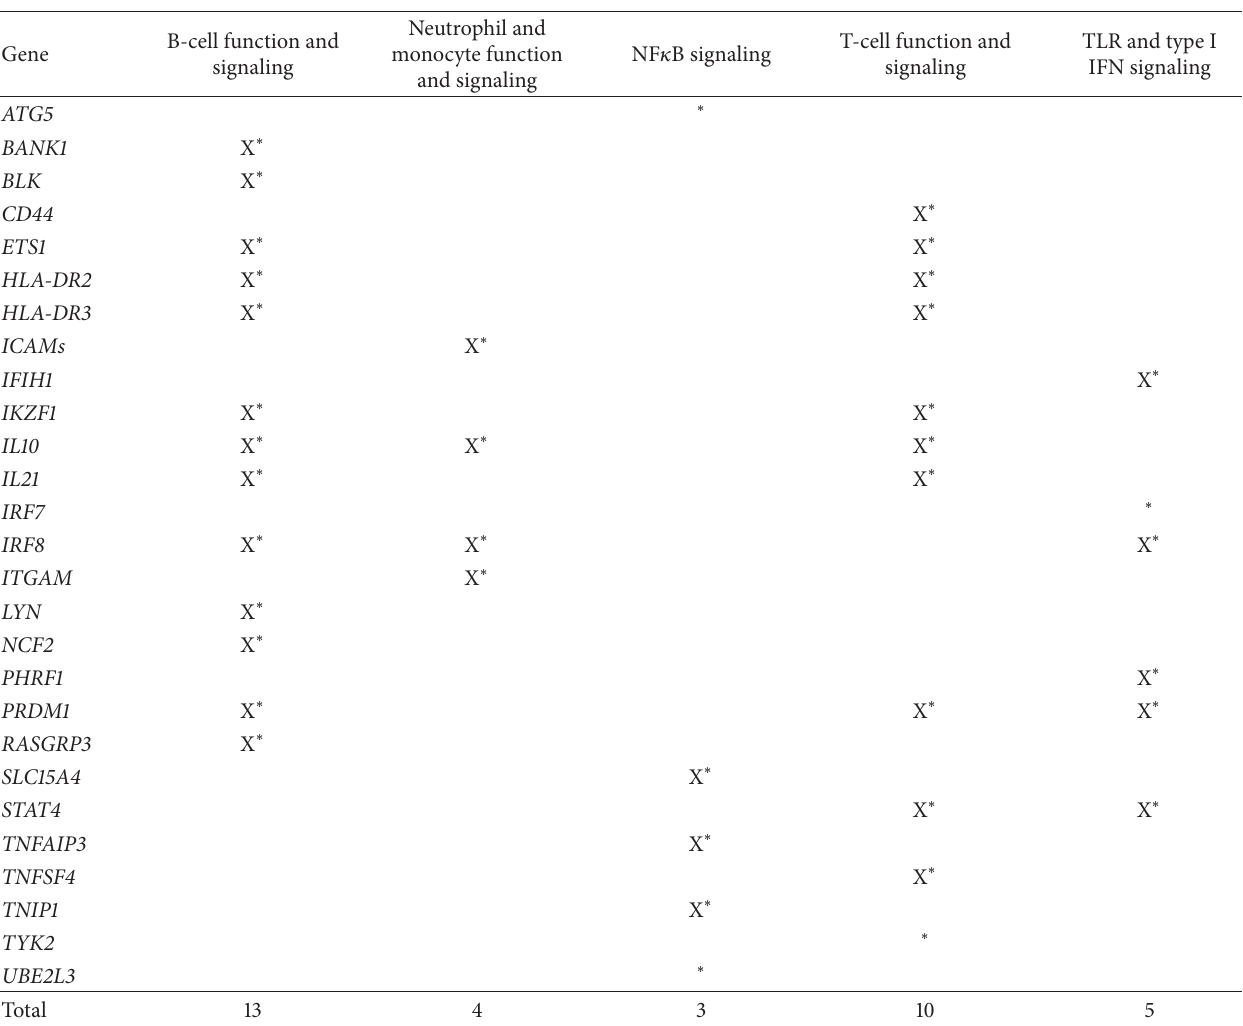
Table 2: Replicated genes and five immune-related pathways. Cells marked with an X represent presence of SNPs associated with SLE in those genes in either cohort. ∗ Marks genes present in the pathway. Neutrophil and B-cell function and T-cell function and TLR and type I Gene monocyte function NF 𝜅 B signaling signaling signaling IFN and signaling